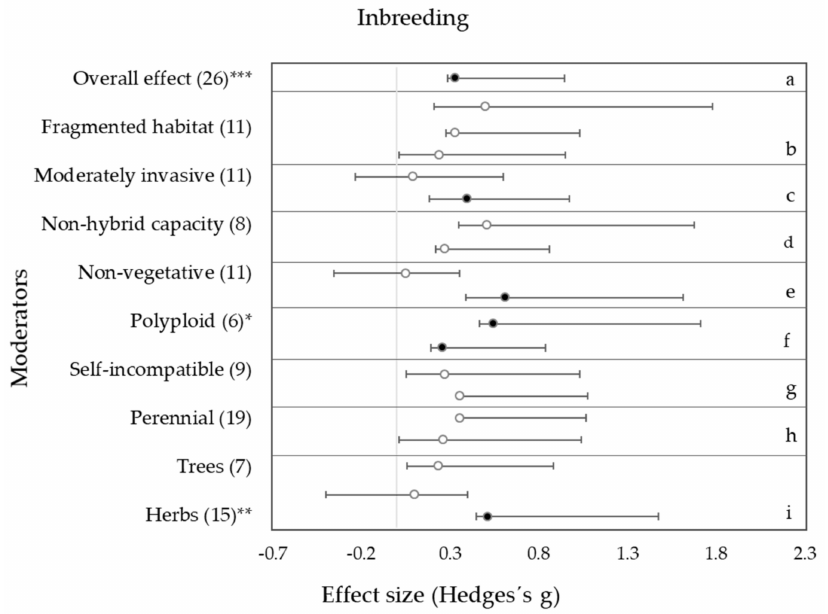
Figure 4. Effect sizes on inbreeding: ( a ) overall effect, ( b ) habitat condition, ( c ) invasiveness, ( d ) hybrid capacity, ( e ) vegetative propagation, ( f ) ploidy level, ( g ) mating systems, ( h ) lifespan, ( i ) life form (mean and 95% CI; numbers in parentheses represent sample size; * p < 0.05, ** p < 0.01, *** p < 0.001; not significant, p ≥ 0.05). Black dots represent a significant effect on